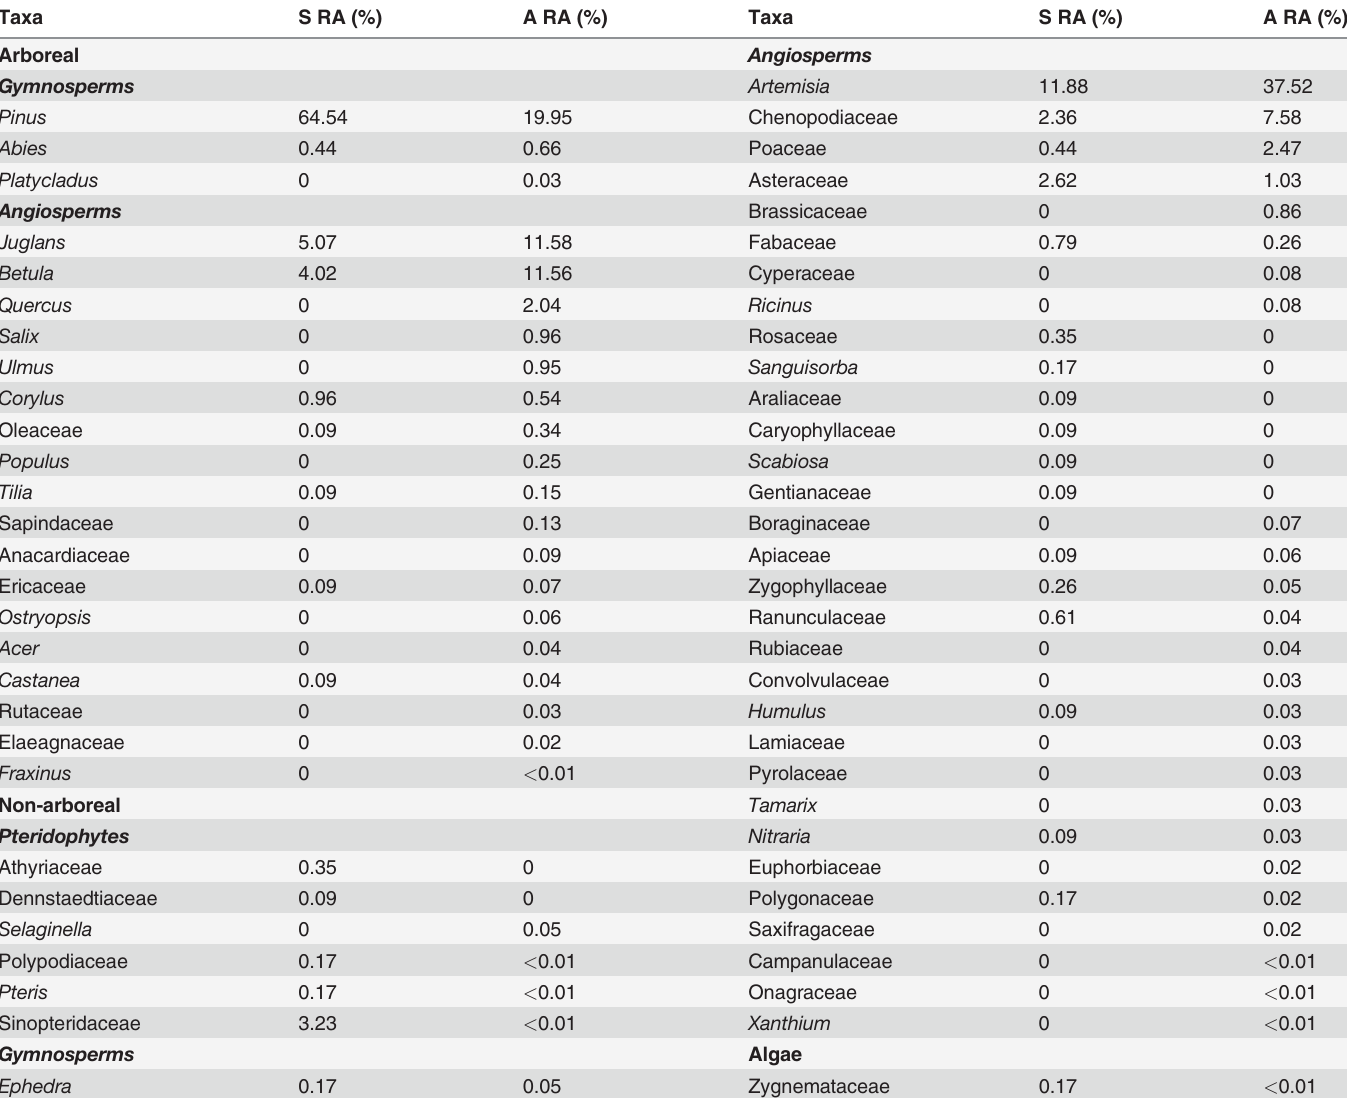
Table 2. The list of the palynomorphs and their relative abundances of temperate forest in Dongling Mountain, Beijing, northern